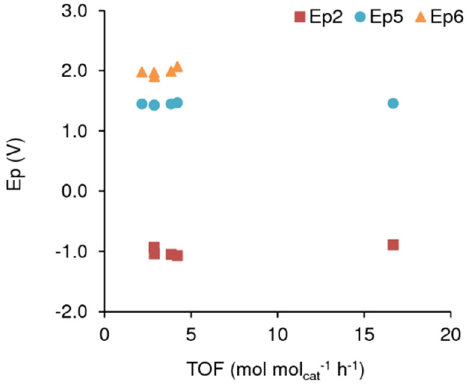
Figure 3. TOF versus CV results (Ep 2 , Ep 5 and Ep 6 ). Reaction conditions: 1 mol.% Mo, molar ratio TBHP:Cy = 1.6, TFT as solvent, 70 °C.